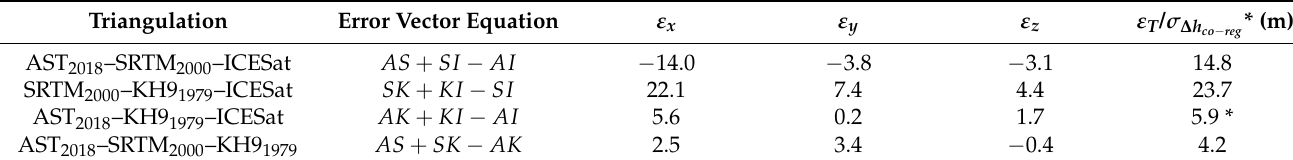
Table 6. Estimated uncertainty of co-registration Method 1. ε X , ε Y , and ε Z are expressed in meters. Each error shift vector component, i.e., ε X , ε Y , and ε Z is obtained following its corresponding error vector